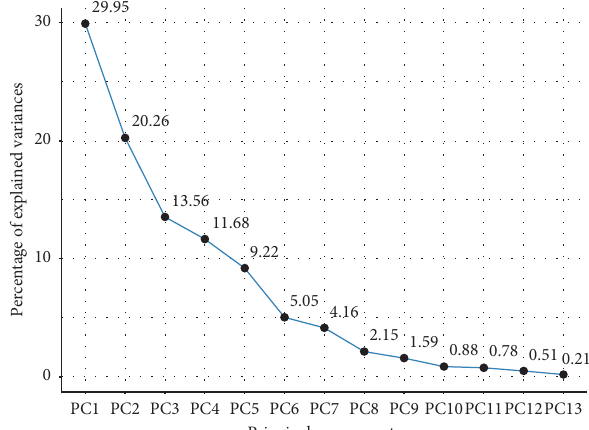
Figure 2: Contribution of each principal component to total explained variance in the phenotypic diversity of rice landraces.